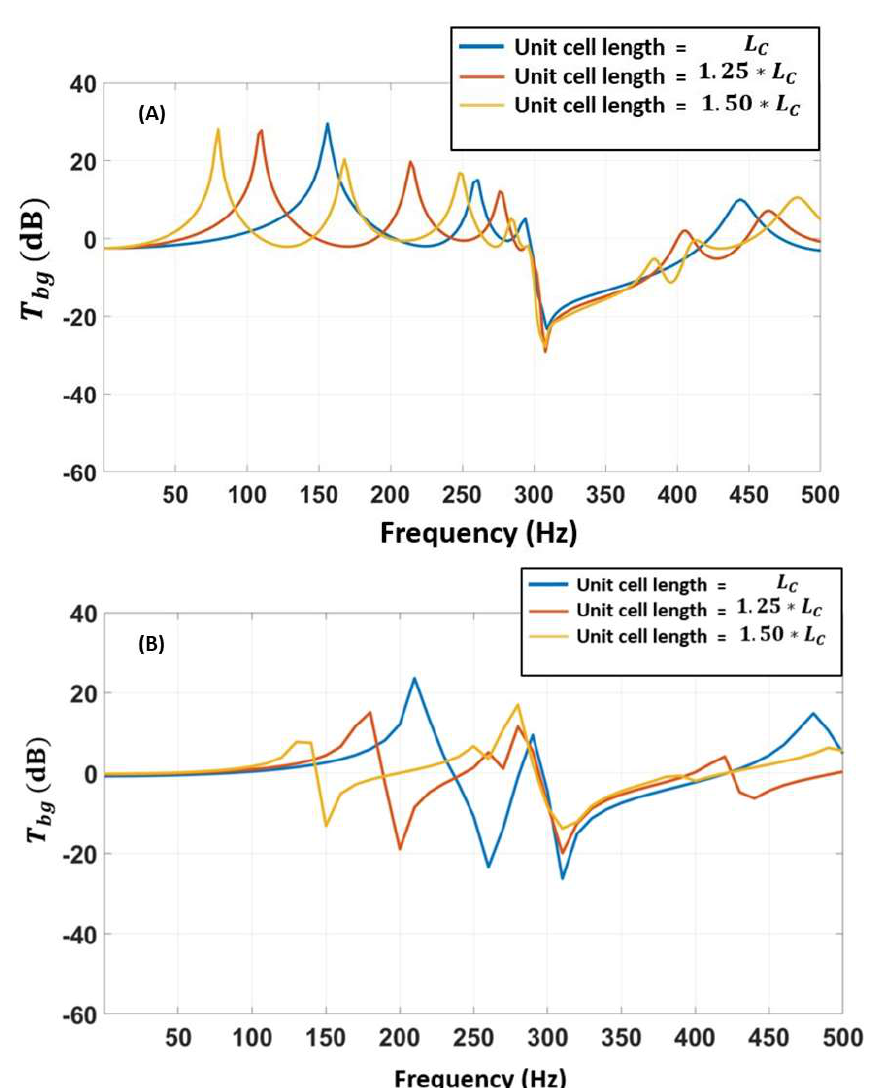
Figure 9. The effect of length of unit cells on transmissibility and frequency bandgaps: ( A ) A single-beam metamaterial structure with 8 local resonators per horizontal beam; ( B ) a double-beam metamaterial structure with 8 local resonators per horizontal beam. The lengths of the unit cells are changed from L C , to [ 1.25 × L C ] and [ 1.50 × L C ].